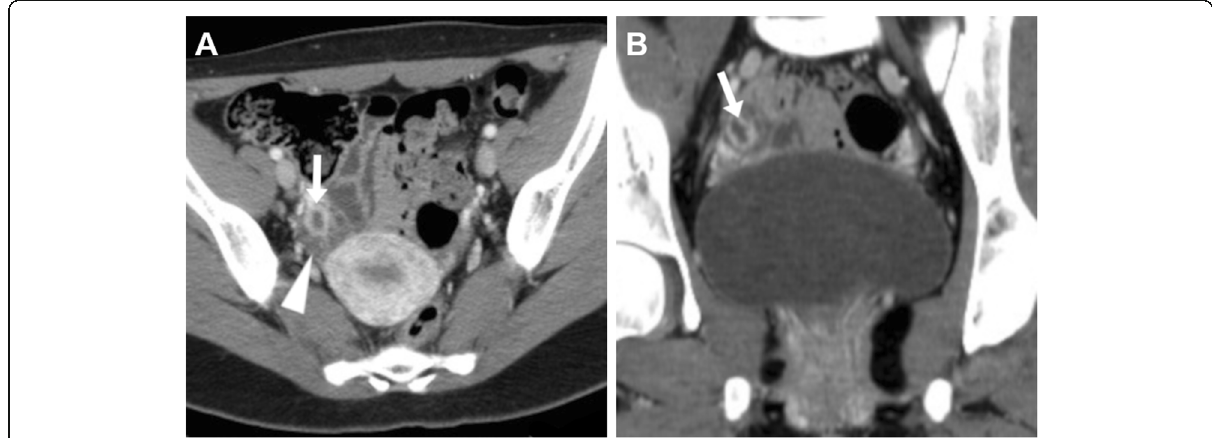
Fig. 1 Typical appearance of an uncomplicated corpus luteum in the second half (luteal phase) of the menstrual cycle on axial ( a ) and coronal ( b ) CT images: the normal-sized right ovary (arrowhead) contains a 1.5-cm cystic structure demarcated by a crenulated, strongly enhancing peripheral rim